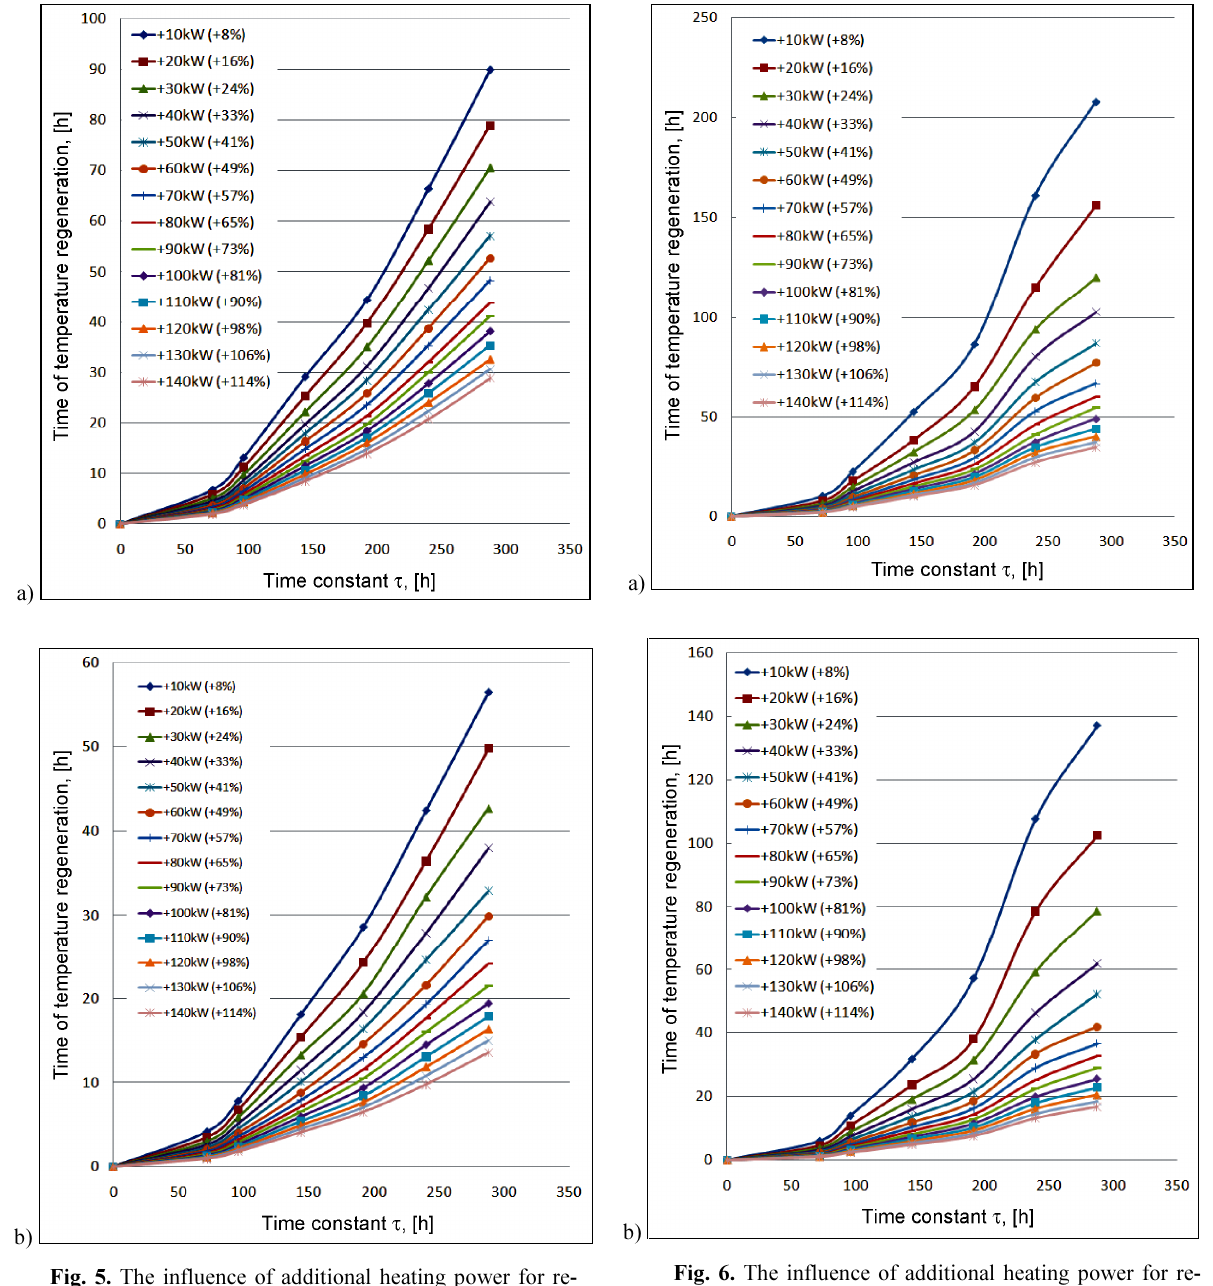
Fig. 5. The influence of additional heating power for re- heating of building premises, under the “average” outdoor temperature conditions: (a) reheating from 0 ° C to 22 ° C, (b) reheating from 10 ° C to 22 ° C